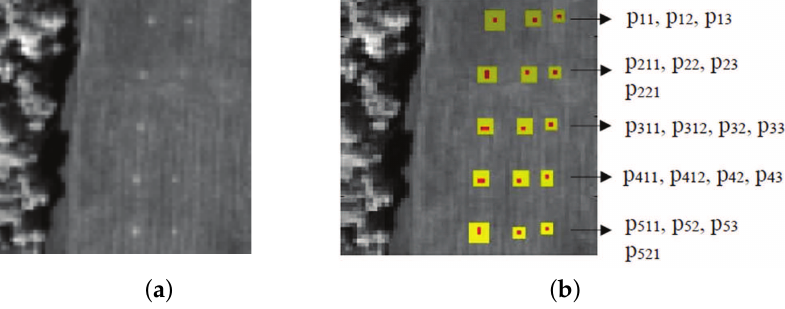
Figure 7. ( a ) A Hyperspectral Digital Imagery Collection Experiment (HYDICE) panel scene which contains 15 panels; ( b ) Ground truth map of spatial locations of the 15